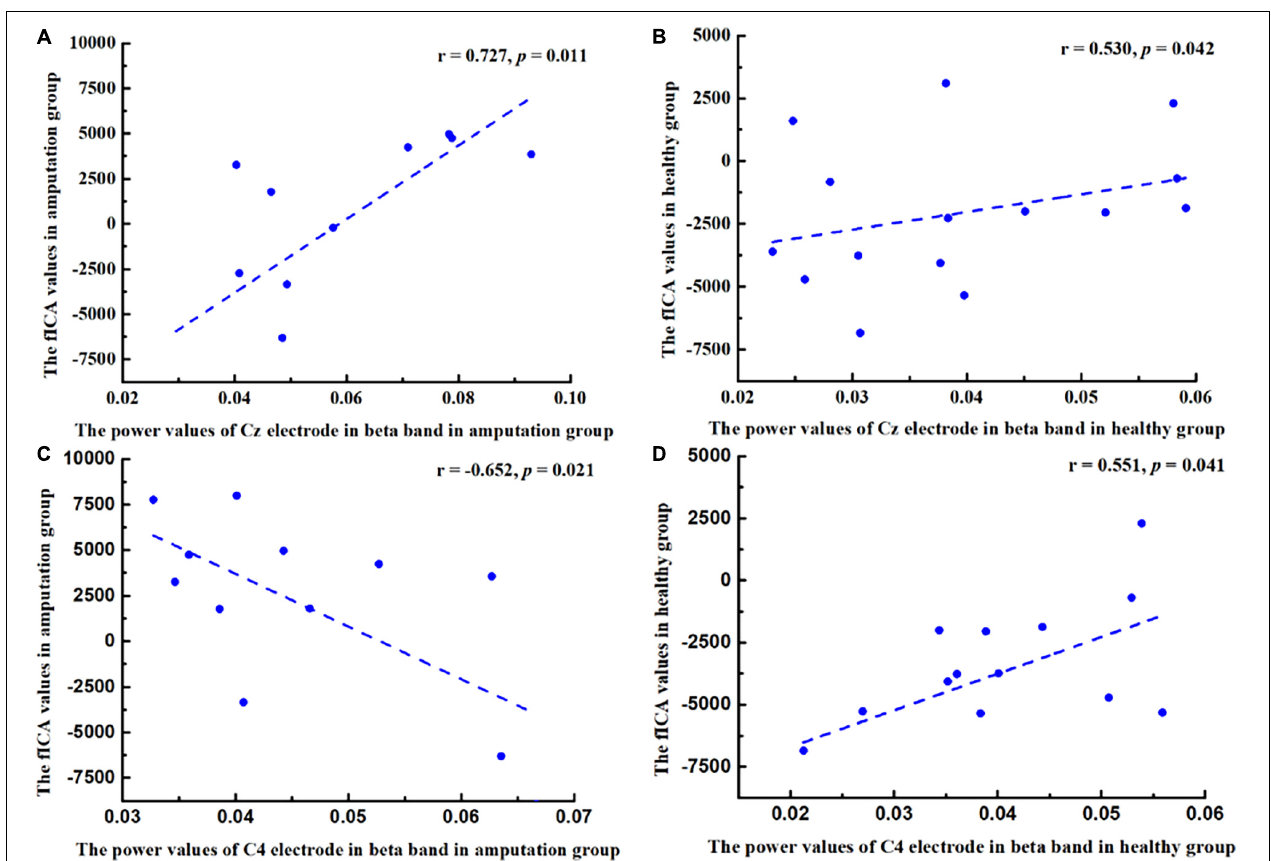
FIGURE 5 | Pearson correlation coefficient between changes in power values of beta band (13–30 Hz) and changes in functional independent component analysis (fICA) values. (A) A positive correlation was found between Cz power values and fICA values in amputee group ( r = 0.727, p = 0.011). (B) A positive correlation was found between Cz power values and fICA values in healthy group ( r = 0.530, p = 0.042). (C) A negative correlation was found between C4 power values and fICA values in amputee group ( r = − 0.652, p = 0.021). (D) A positive correlation was found between C4 power values and fICA values in healthy group ( r = 0.551, p = 0.041).